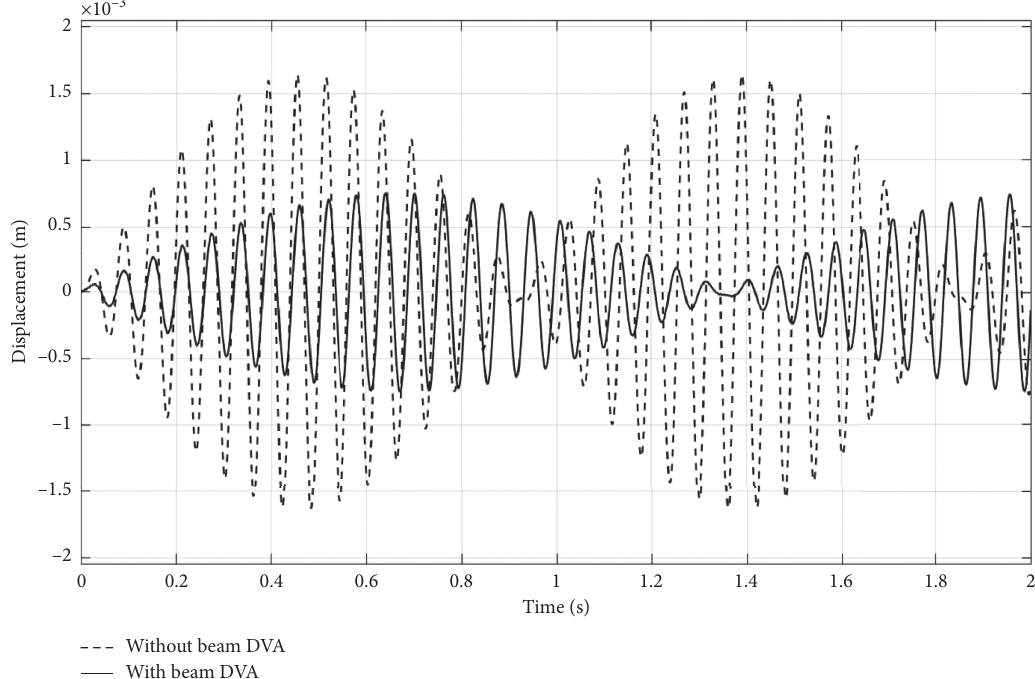
Figure 11: Numerical results of the 2-inch pipeline structure under the excitation frequency of 16Hz.